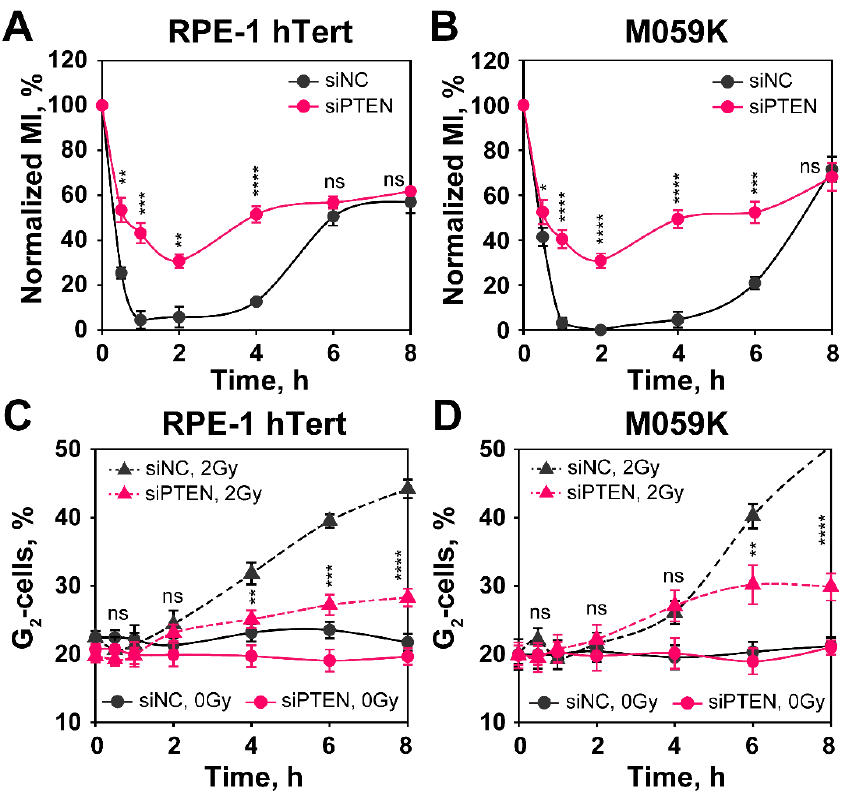
Figure 7. PTEN knock-down impairs G 2 -checkpoint activation in RPE-1 hTert and M059K cells. The checkpoint activated in cells that are in G 2 -phase at the time of irradiation is measured by analyzing the mitotic index (MI), using two-parameter flow cytometry detecting DNA through PI staining and phosphorylated H3 at Serine 10 (H3pS10), a specific marker of mitotic cells, by antibody staining. ( A ) Normalized MI in siNC and siPTEN transfected RPE-1 hTert cells. Normalized MI is calculated by dividing the MI measured in irradiated cells by that of non-irradiated cells. ( B ) Same as in panel ( A ), but for M059K cells. ( C ) Single parametric flow cytometry analysis of siNC and siPTEN transfected RPE-1 hTert cells showing the activation of the G 2 -checkpoint of S-phase irradiated cells. ( D ) Same as in panel ( C ), but for M059K cells. Data from three independent experiments are presented as mean ± SD. The significance level, or p -value, is calculated using the two-tailed Student´s t -test: ns (not significant), * p < 0.05, ** p < 0.01, *** p < 0.001, **** p < 0.0001.